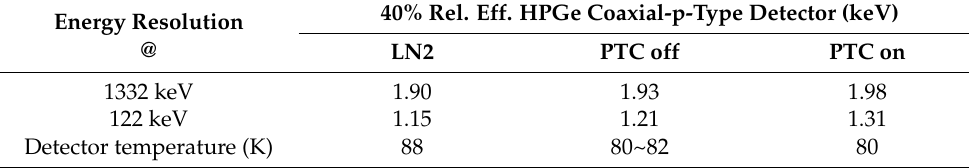
Figure 11. Co60 and Co57 energy resolution with PTC switched on.